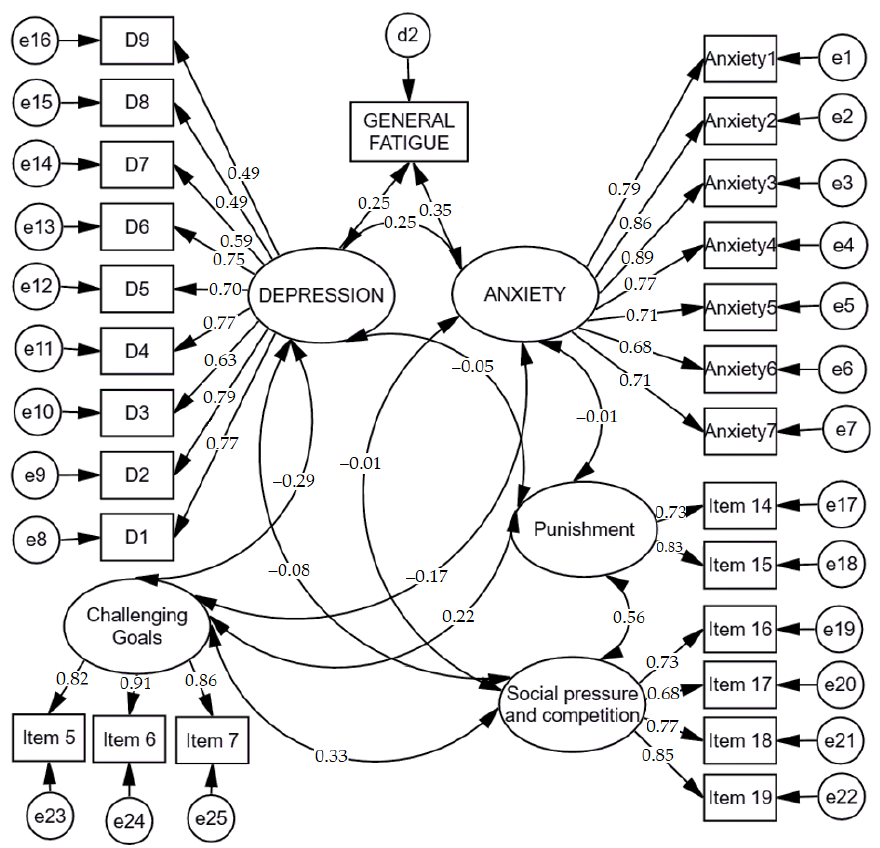
Figure 2. Standardized results of the model of associations between learning motivating factors (challenging goals, punishment, social pressure, and competition), anxiety, depression, and fatigue in the group of respondents who did not participate in e-learning-based computer programming courses.